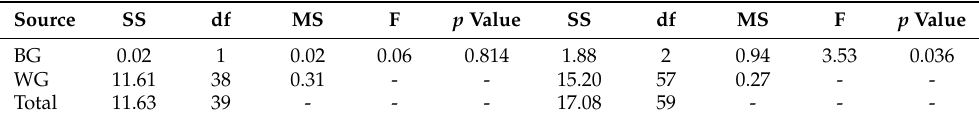
Table 8. Using the BIDMC dataset, the ANOVA results of the left side columns were obtained from the GBAMF and CAGBA; the right side columns were obtained from SVRMF, LSTMMF and GBAMF